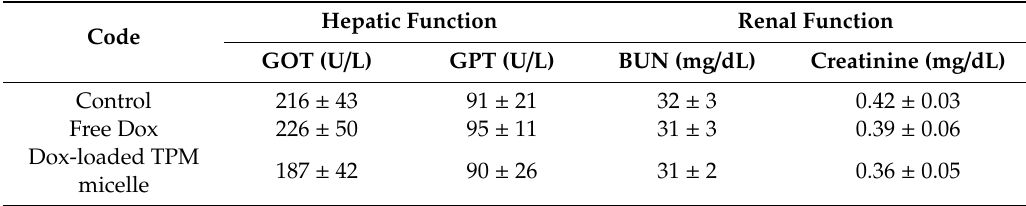
Table 2. Hepatic and renal function